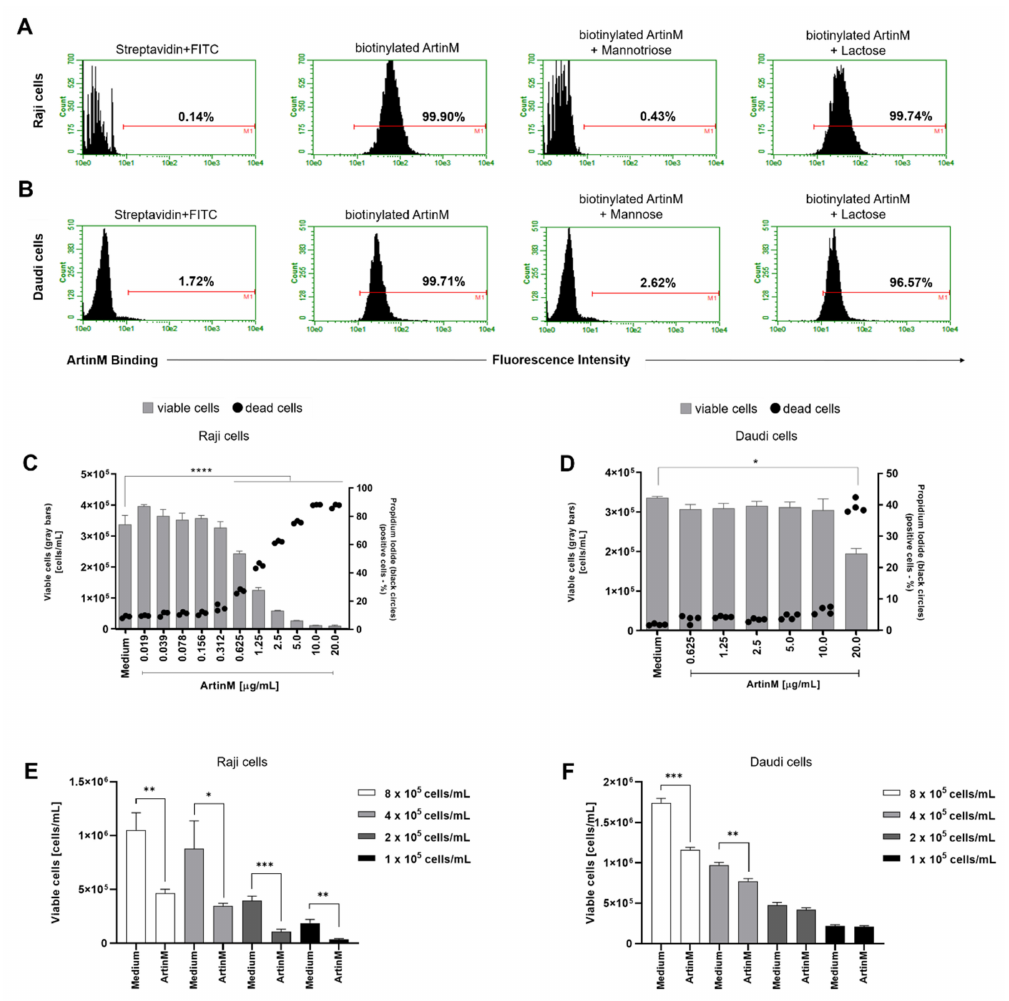
Figure 3. ArtinM binds Raji and Daudi cell surface through carbohydrate recognition, reducing Raji cells’ viability and increasing death. ( A ) Raji and ( B ) Daudi cells (1 × 10 6 cells/mL) were fixed and incubated with biotinylated ArtinM (20 µ g/mL), pre-treated or not with mannotriose (1 mM), mannose (20 mM) or lactose (20 mM). After washing, streptavidin-FITC (5 µ g/mL) was added to the cells, which were analyzed by flow cytometry. Streptavidin-FITC alone was used as a negative control. Histograms represent the fluorescence intensity of cells for ArtinM detection; the positive range is indicated by the red line (M1). ( C ) Raji and ( D ) Daudi cells (1 × 10 5 cells/mL) were distributed in 96-well microplates and incubated for 48 h at 37 ◦ C with ArtinM at different concentrations. Medium alone was used as a negative control (Medium). The percentage of live and the frequency of dead (propidium iodide (PI)-positive) cells was determined by flow cytometry. The number of viable cells (grey bars) and the frequency of PI-positive cells (black circles) are shown in ( C , D ). ( E , F ) Raji and Daudi cells at different concentrations (1 to 8 × 10 5 cells/mL) were distributed in 96-well microplates and incubated for 24 h at 37 ◦ C with ArtinM (1.25 µ g/mL for Raji cells and 20 µ g/mL for Daudi cells). The concentration of viable cells was measured by flow cytometry using PI staining to determine the dead cells. The results are expressed as mean ± standard error of the mean (SEM); data are representative of three independent experiments performed in quadruplicate. Significant differences compared to the medium are shown by *, p < 0.05; **, p < 0.01; ***, p < 0.001; and **** p <